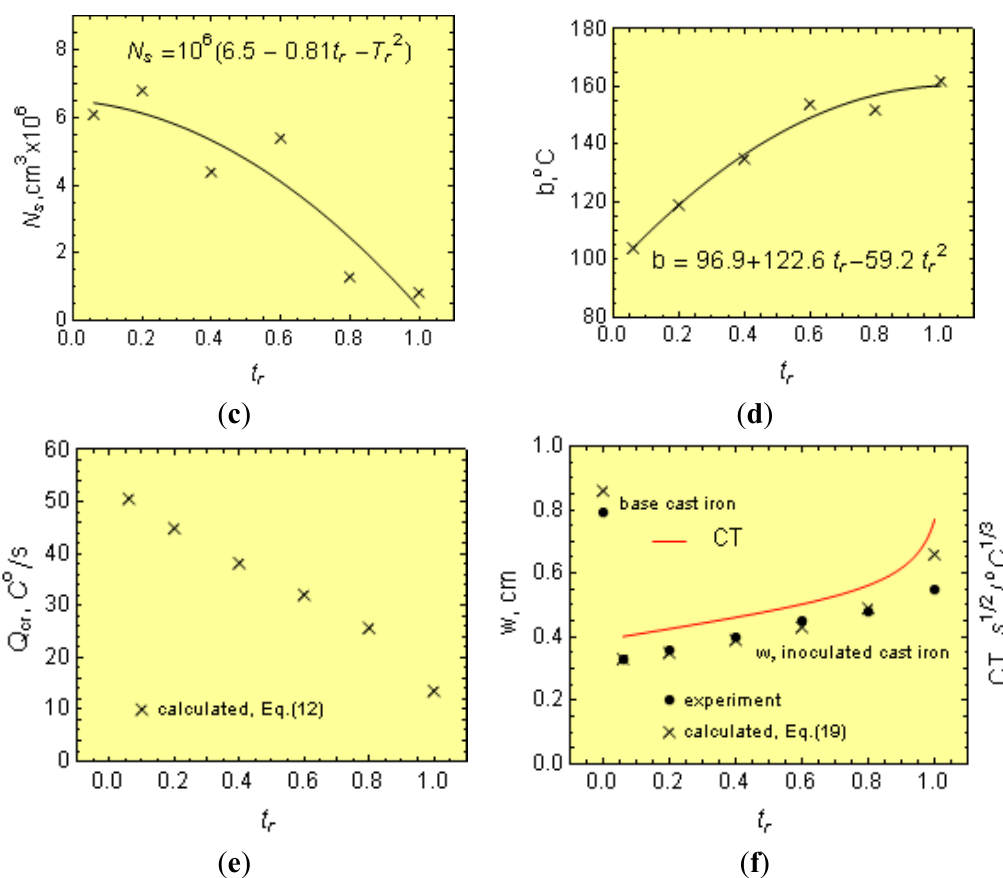
Figure 25. Effect of t r after inoculation on ( a ) N F , ( b ) Δ T m , ( c ) N s , ( d ) b , ( e ) the CT index and ( f ) w.